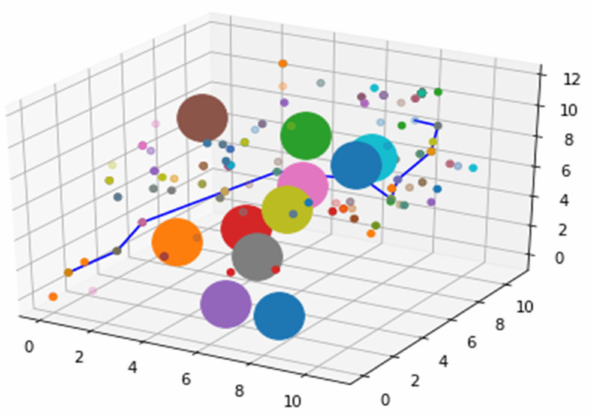
Figure 3. Path planning diagram of the classic RRT algorithm.